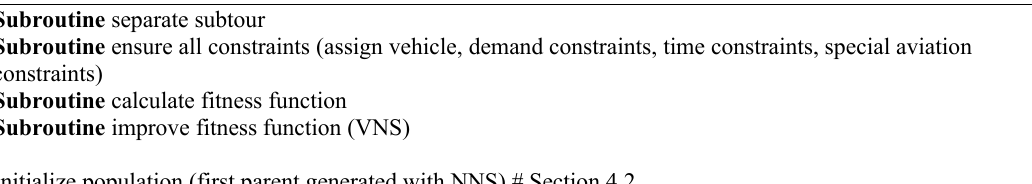
Algorithm 1. ( HGA-VNS framework